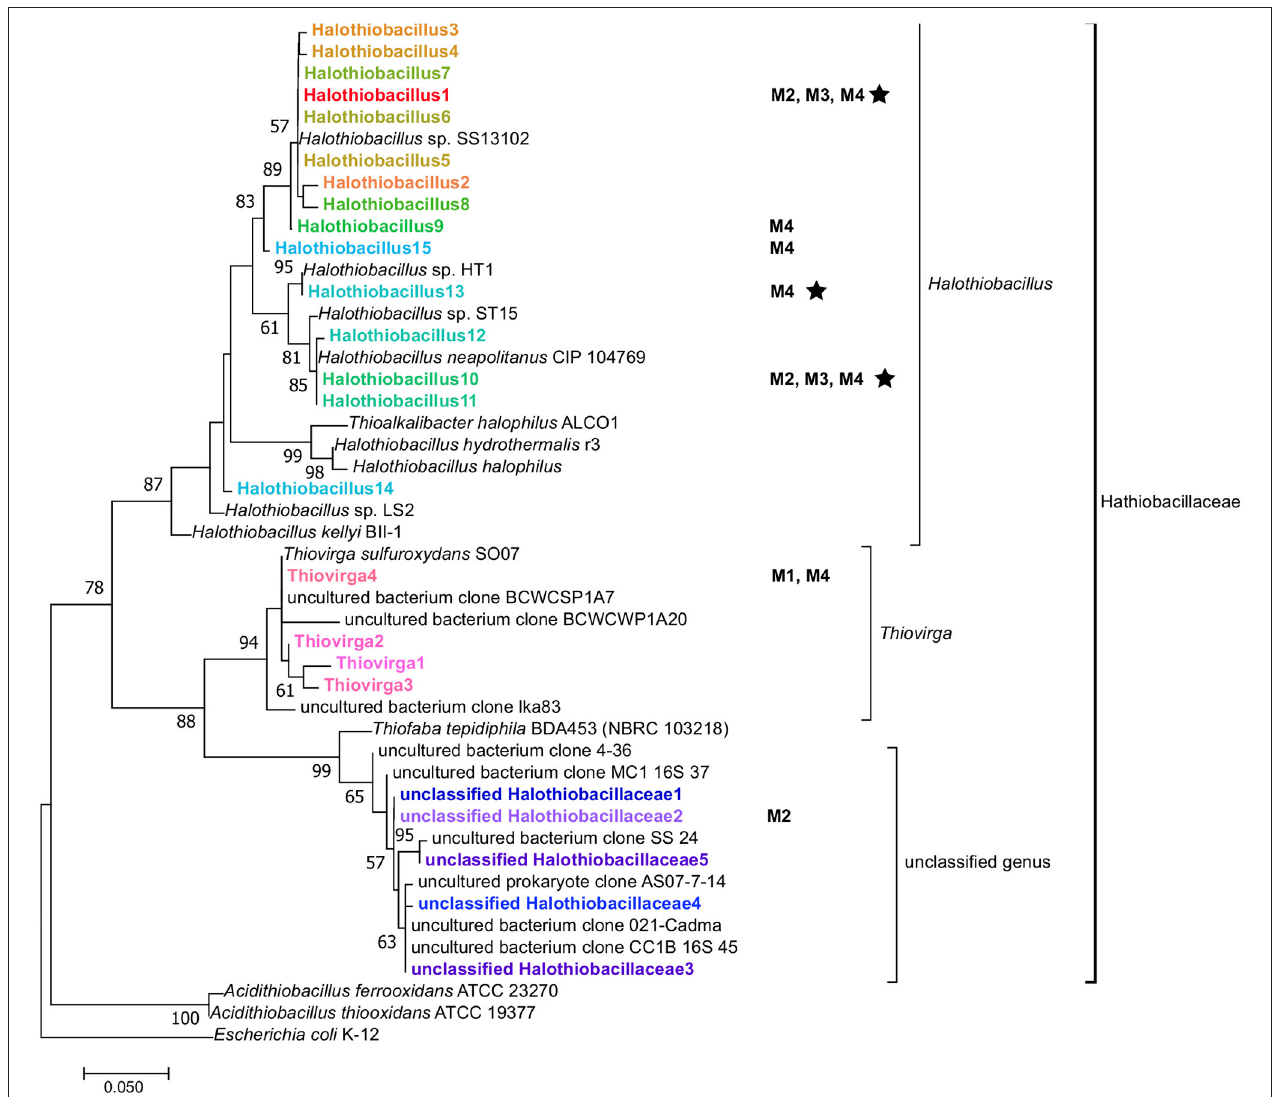
FIGURE 4 | Maximum-likelihood phylogenetic tree of 16S rRNA gene amplicons ( ∼ 264 bp) of the family Halothiobacillaceae detected from different mine parent water samples (M1–4) and SoxBac enrichments (in bold) showing the affiliation of sequences of the family Halothiobacillaceae . Reference genes of known Halothiobacillaceae (isolates and uncultured clones), and Acidithiobacillus spp. in the databases of SILVA and NCBI are also shown and the tree was rooted with E. coli K-12. The tree was created with 1,000 bootstrap iteration and the values below 50% are not reported. The scale bar represents 5% sequence divergence. Some amplicons are shown with their origins (Mines 1 to 4 (“M1–M4”) when their relative abundances in whole microbial 16S rRNA gene community are more than 1%. The star symbol indicates organisms that were cultured in the SoxBac enrichments from the parent mining